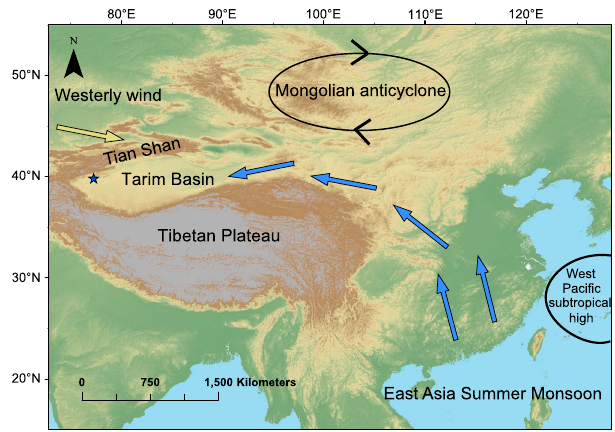
westward moisture transport 41 , which is shown by the blue arrows. Star shows the location of the study